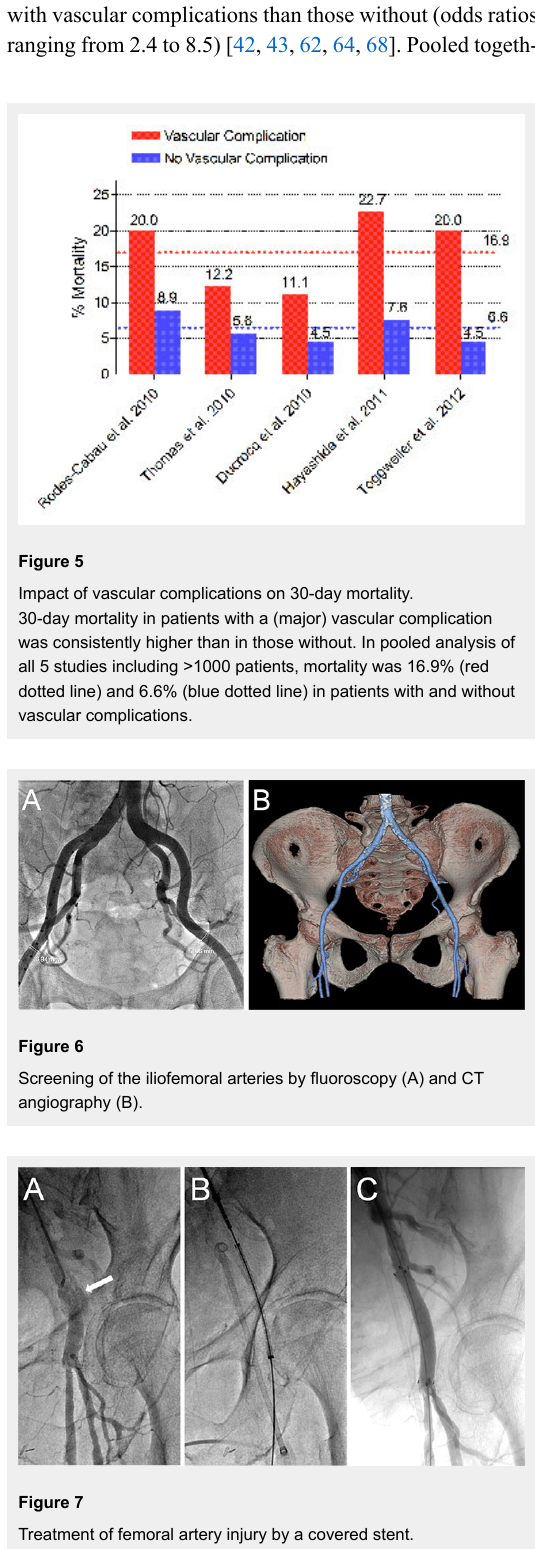
Treatment of femoral artery injury by a covered stent. This patient presented with acute haemorrhage of the femoral artery (A). Bleeding was controlled by balloon tamponade, after which a Fluency Plus 9 x 60 mm covered self-expanding stentgraft (Bard Canada Inc., Oakville, Canada) was implanted with a good result (B,